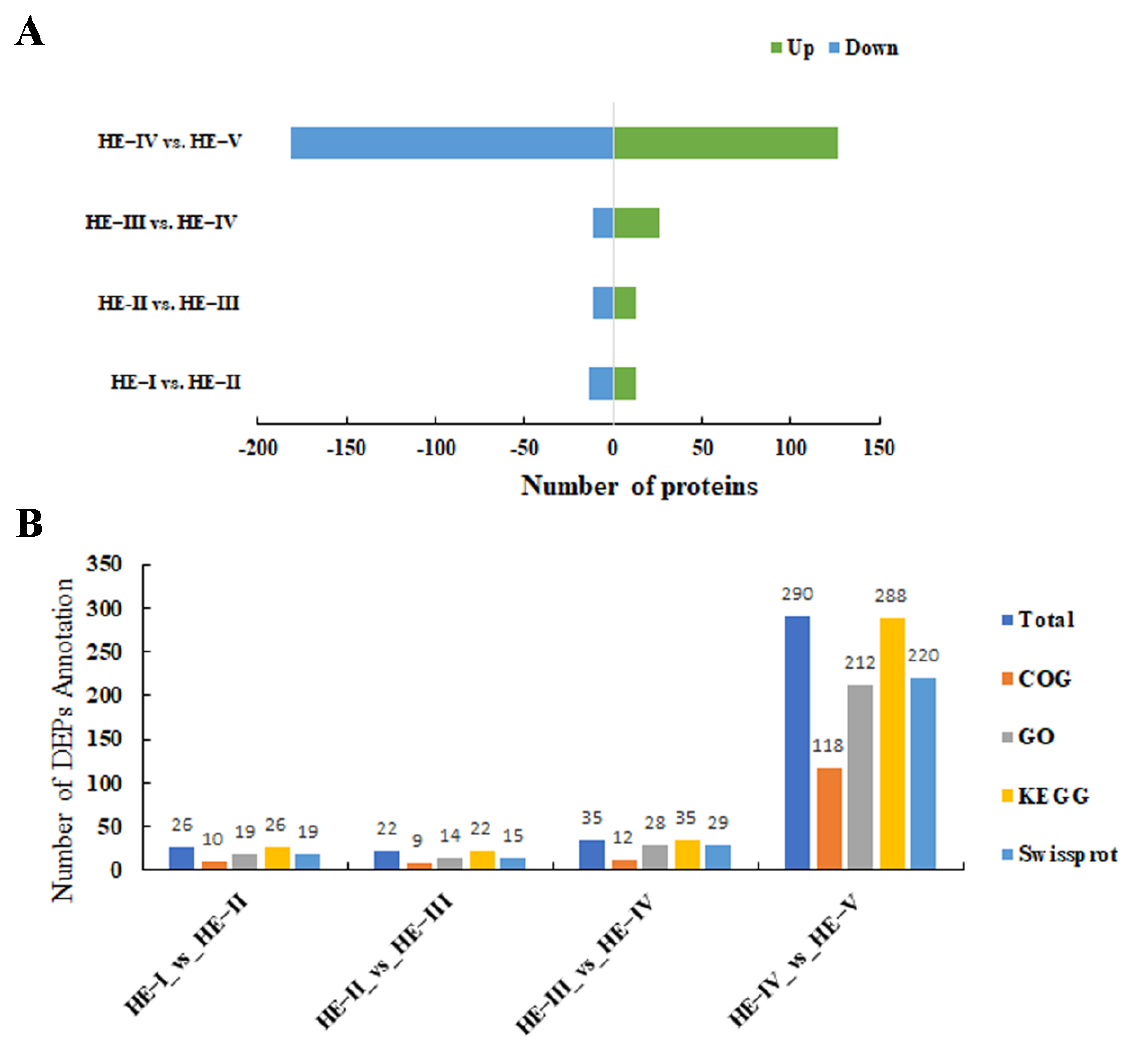
Figure 3. The analysis of ( A ) number of up- and downregulated DEPs. ( B ) Functional classification of DEPs with the COG, GO, Swissprot, and KEGG database in HE-I vs. HE-II, HE-II vs. HE-III, HE-III vs. HE-IV, and HE-IV vs. HE-V groups. Table 2. Top 3 up/down regulated DEPs identified in hepatopancreas of M. nipponense in four compared